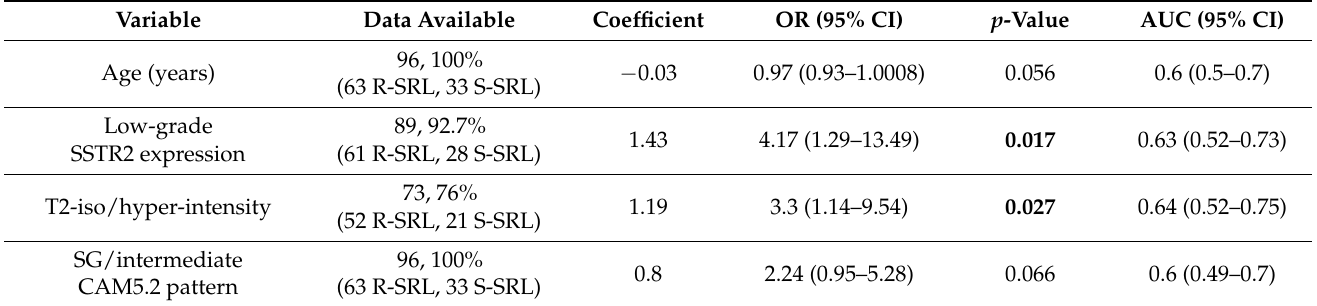
Table 4. Univariate logistic regression analyses on predictors of resistance to fg-SRL, selected from those significantly associated with non-response to treatment in bivariate regression